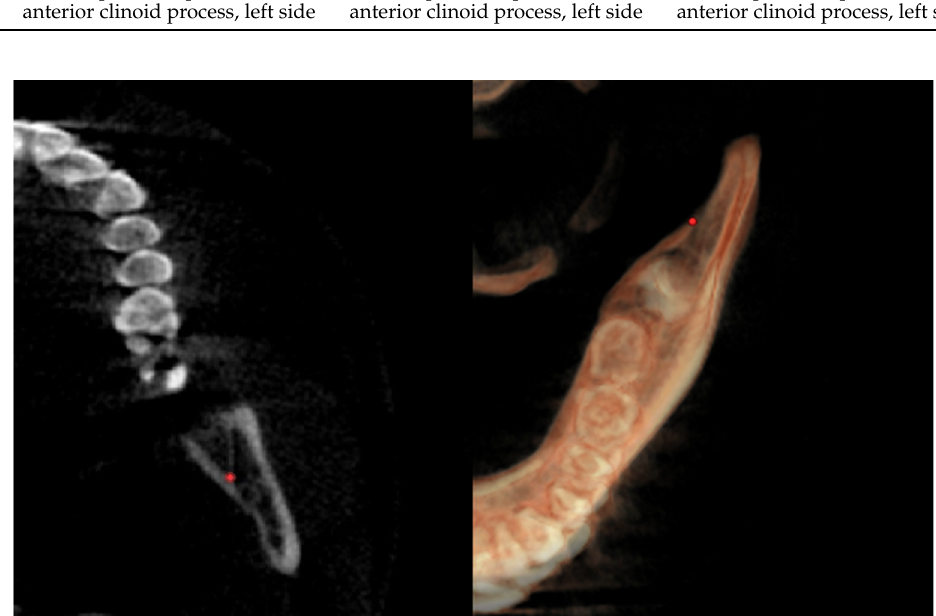
Figure 5. CBCT images showing the anatomical lingual tuberosity.